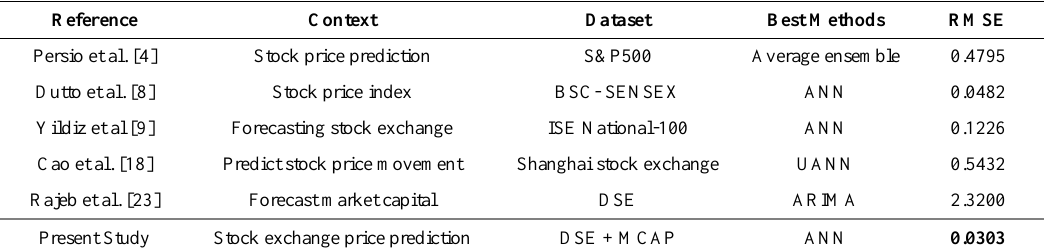
Table 7. The forecast accuracy measures for selected ARIMA and ANN